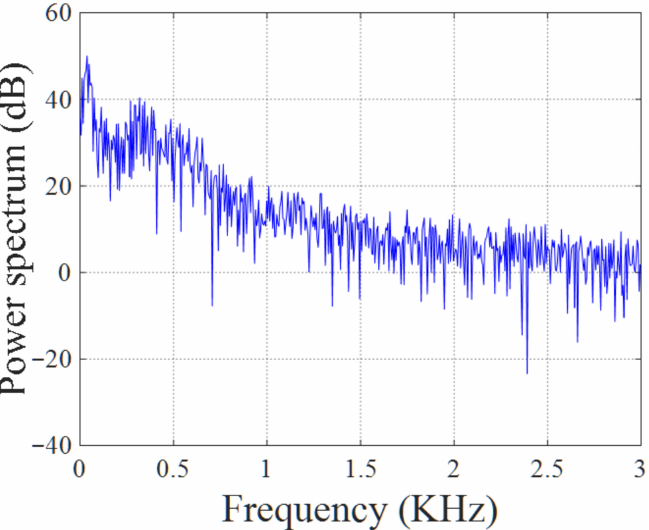
Figure 9. The power spectrum frequency of the output signal from Lur’e system with time delay τ = 0.6 ms and sampling frequency f s = 4